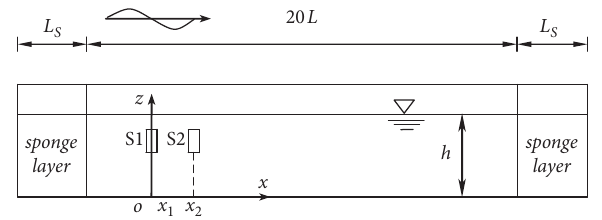
Figure 1: Sketch of the numerical wave